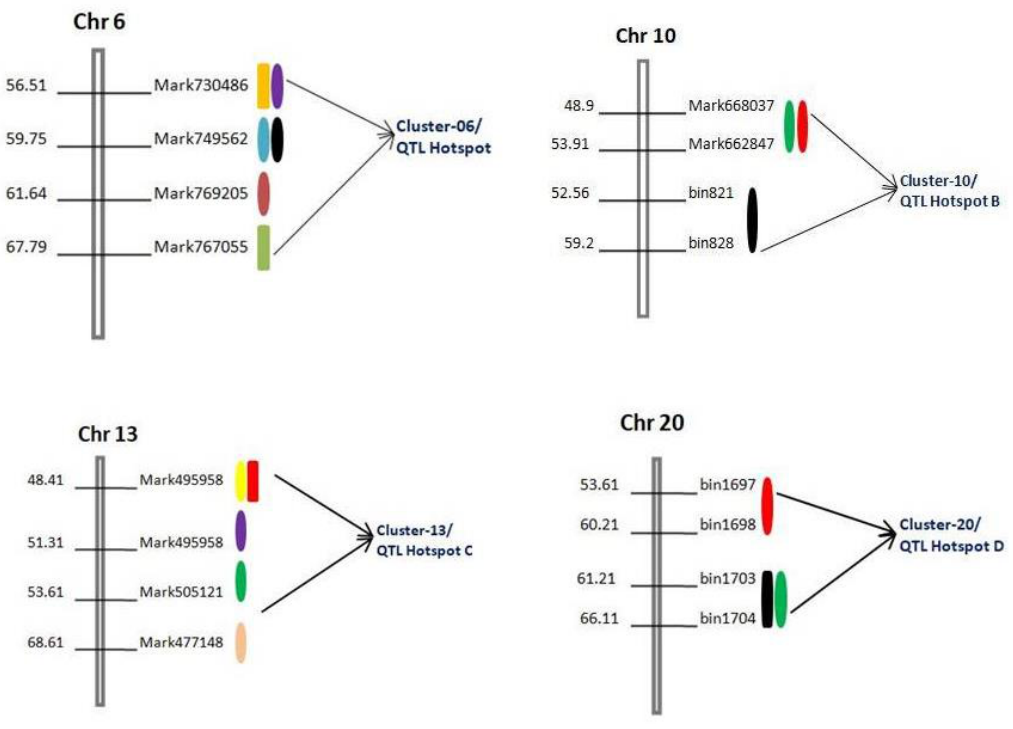
Figure 3. Diagram showing the physical location of four QTL clusters/hotspot regions (cluster-06, cluster-10, cluster-13, and cluster-20) on four different chromosomes viz., Chr6, Chr10, Chr13, and Chr20 identified in two RIL populations across multiple environments Different colors indicate different QTLs within same region.